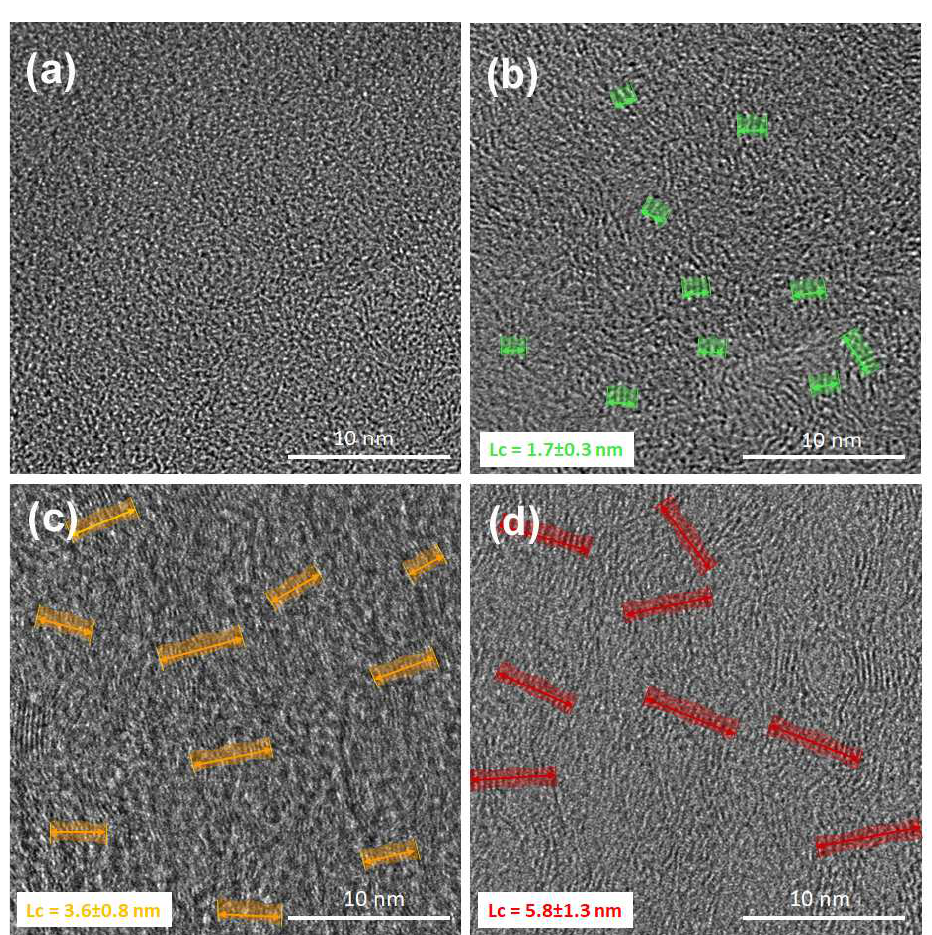
Figure 4. HRTEM micrographs of the transverse sections: ( a ) eCNF750, ( b ) eCNF1000, ( c ) eCNF1750 and ( d ) eCNF2000.